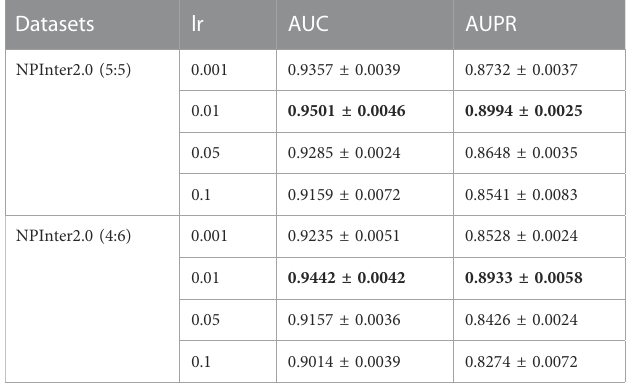
Bold values are the best performance of each task.